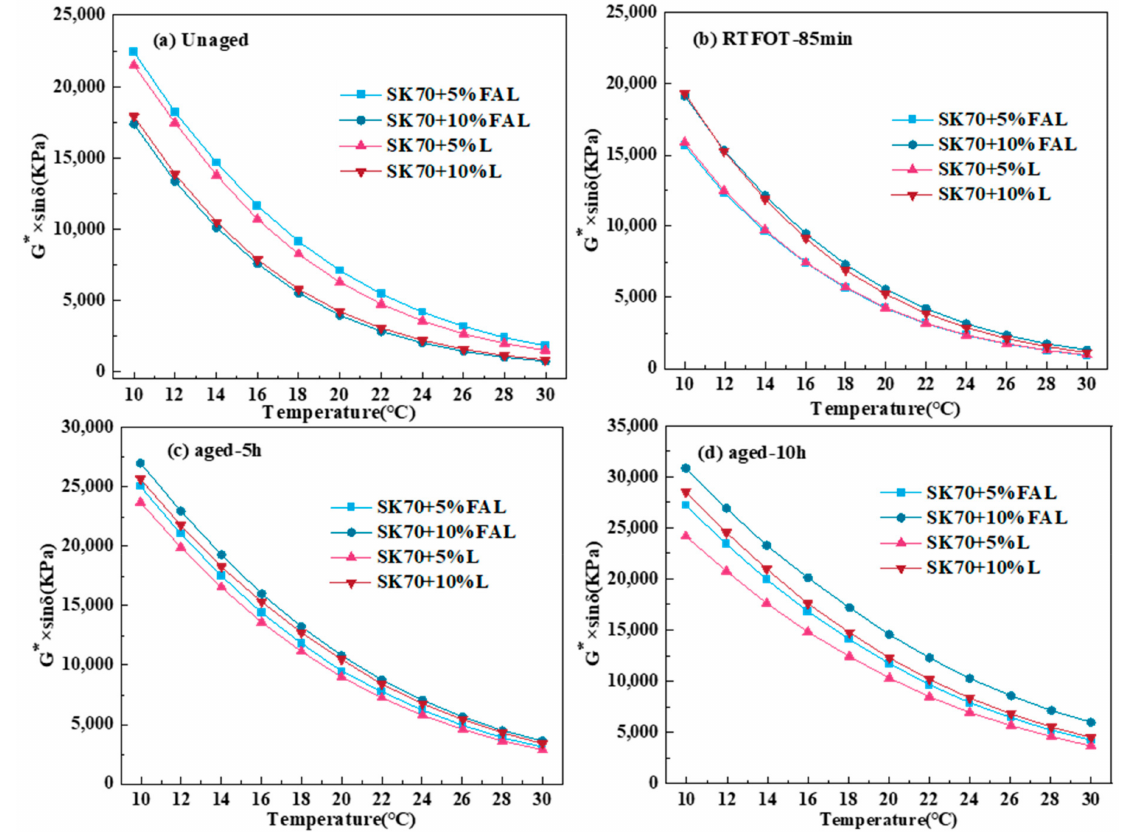
Figure 9. Curves of fatigue factor with temperatures for each asphalt specimen in different